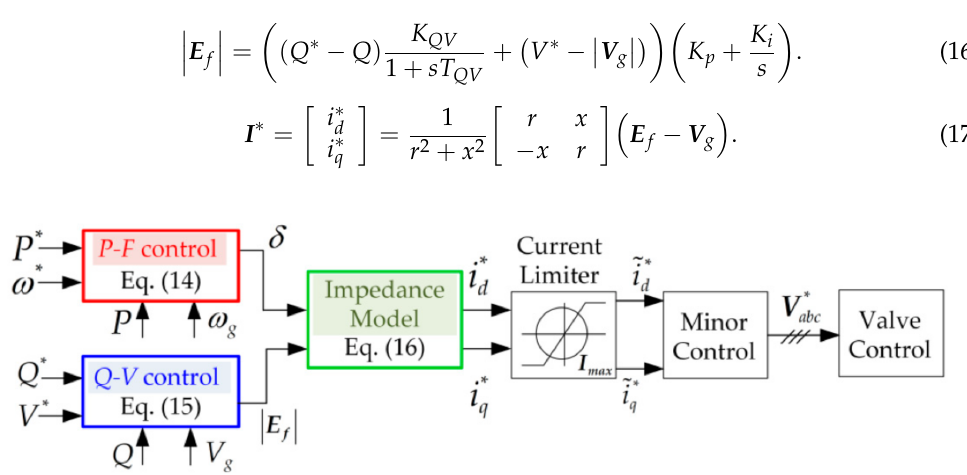
Figure 3. Control block diagram of the Kawasaki virtual synchronous generator (VSG).